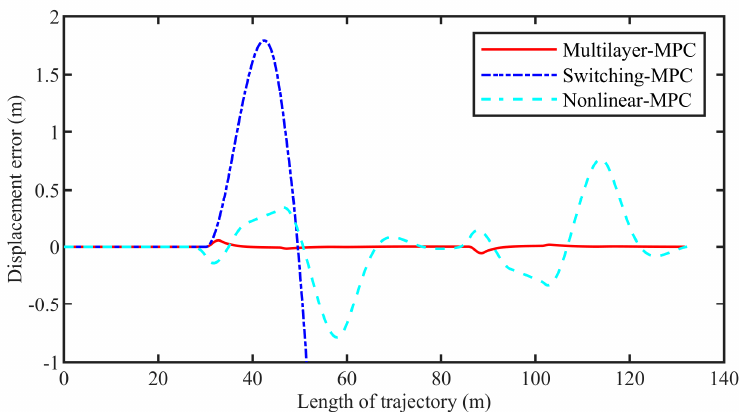
Figure 8. Displacement error of the comparison between controllers.